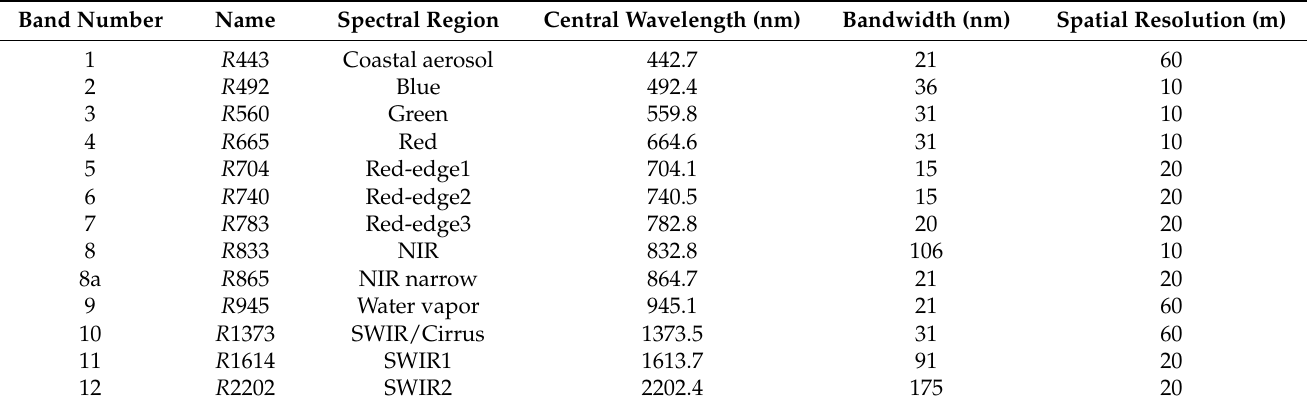
Table 1. Spectral information and spatial resolution of MSI sensor (ESA,